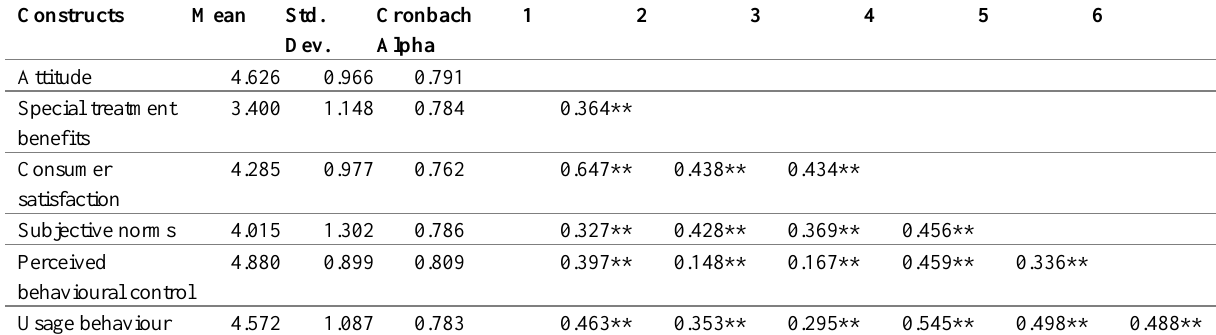
Table 3: Descriptive Statistics, Reliability Measures, and Correlation